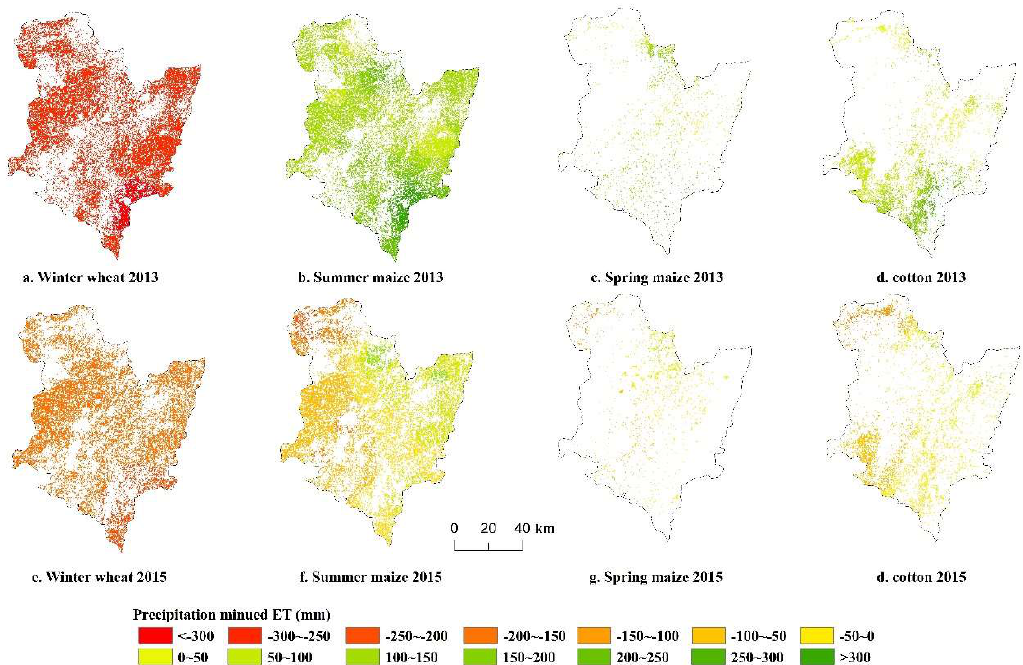
Figure 6. Net irrigation water of main crops in Hengshui. There is a gap between precipitation and ET, which can be considered to be the amount of irrigation required for crops. Since the precipitation for some crops was greater than ET (positive value in the figure), it can be assumed that no groundwater was consumed, and groundwater was replenished; if the precipitation during the crop growth period was less than ET (negative value in the figure), the gap needed to be extracted by groundwater.